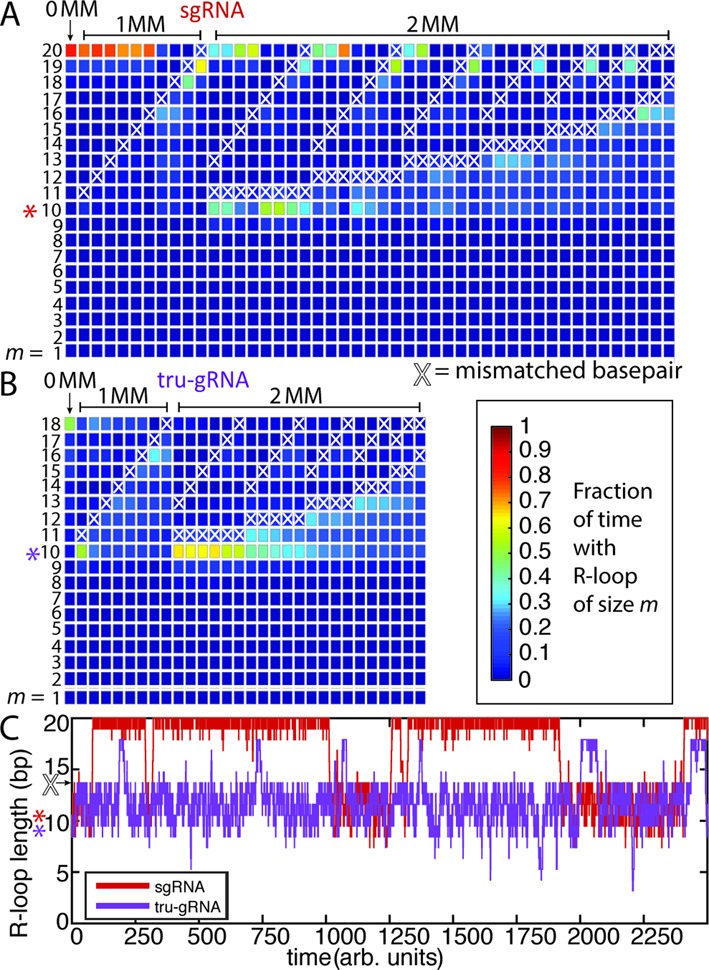
KMC experiments reveal differences in ability to traverse mismatches (MM) and invade the protospacer depending on guide RNA structure. (A–B) Fractional occupancy by time of R-loop lengths m for (A) sgRNA or (B) tru-gRNA during invasion derived from KMC experiments (initiated at m = 10, highlighted by asterisk). White X's indicate positions of mismatches. Simulation run until t ≥ 10 000 (arbitrary units) and the results are averaged over 100 trials. (C) Representative KMC time courses for strand invasion (starting at m = 10) with a mismatched site at m = 14 (arrow) for sgRNA (red) and tru-gRNA (purple). While sgRNAs are largely stably invaded after bypassing a mismatch, tru-gRNAs are repeatedly re-trapped behind the mismatch as a result of the inherent volatility of their R-loops (see Figure 4).